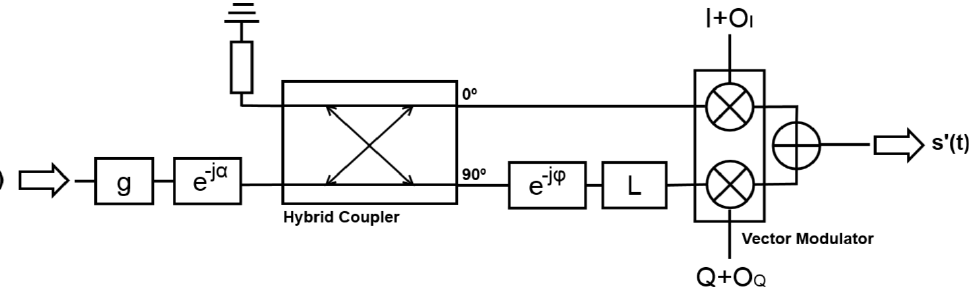
Figure 7. Used model for a whole RF